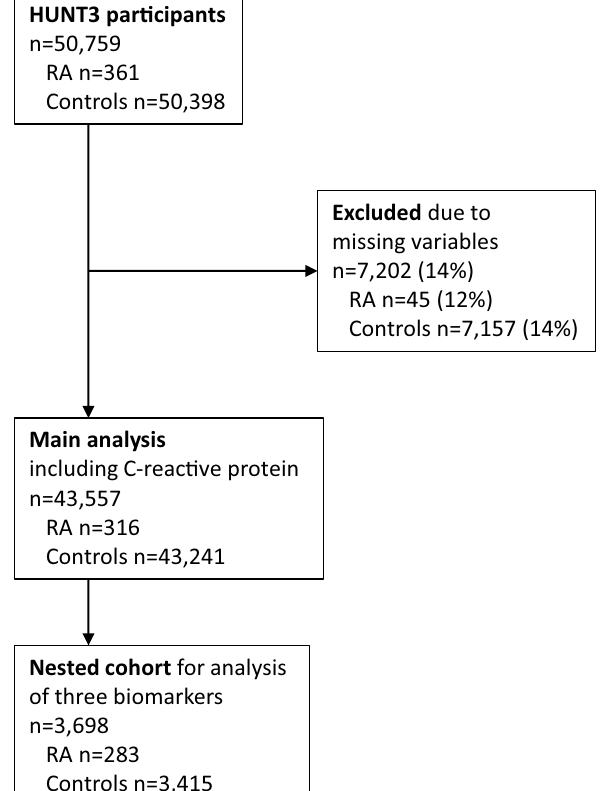
Figure 1. Participant inclusion and exclusion. Participants in the main analysis including C-reactive protein, and the nested cohort study including the biomarkers C-reactive protein, lactoferrin, and neopterin. Missing variables: C-reactive protein (1.5%), body mass index (0.8%), total cholesterol (2.9%), HDL cholesterol (2.9%), smoking (11.3%). HUNT3; 3rd wave of the Trøndelag Health Study